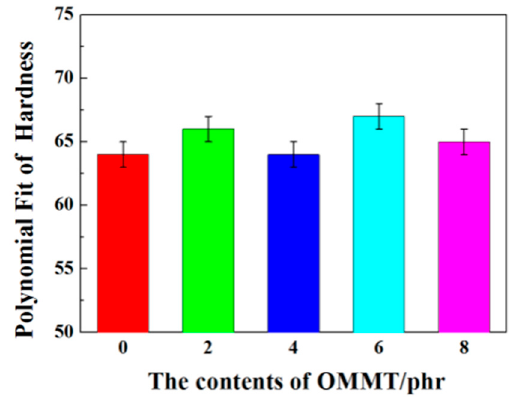
Figure 2. The e ff ects of the contents of OMMT on hardness of vulcanized Figure 2. The effects of the contents of OMMT on hardness of vulcanized rubber.